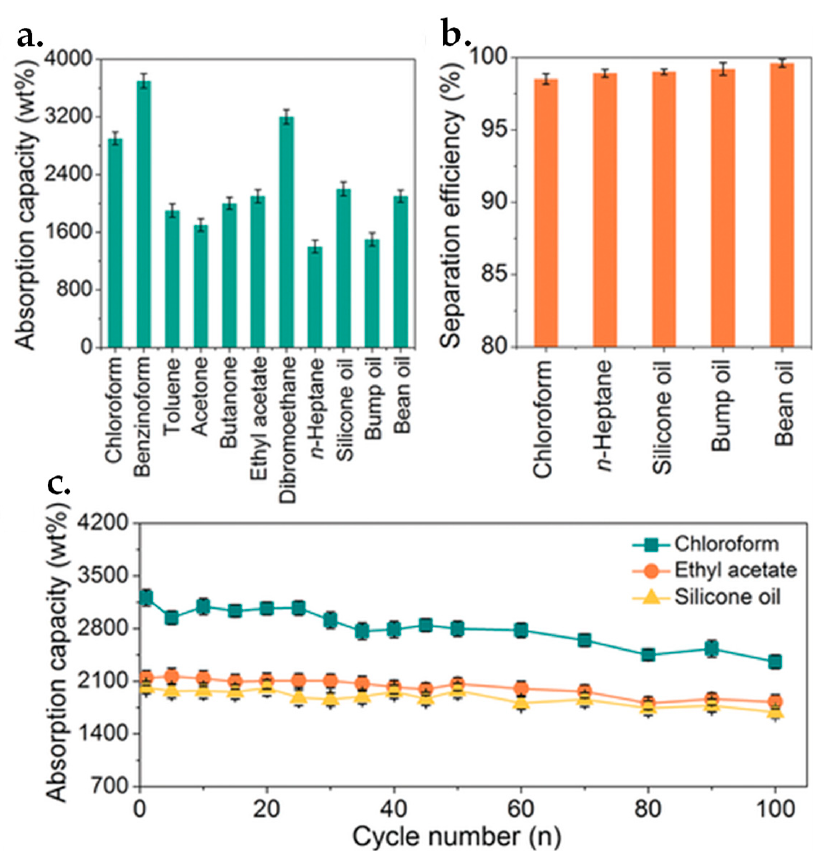
Figure 8. Absorption and separation performances of the ZIF-8@rGO@Sponge on various oils and organic solvents: ( a ) Absorption capacity. ( b ) Separation efficiency. ( c ) Absorption recyclability. Reproduced from [195], with permission from Wiley, 2019.